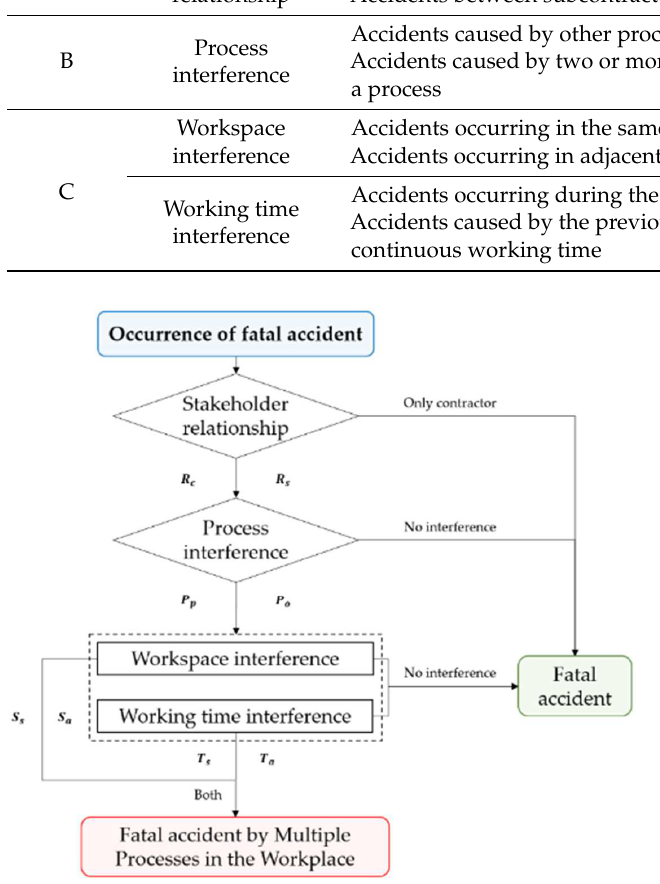
Table 2. Decision process criteria and notation of multiple processes in the workplace.